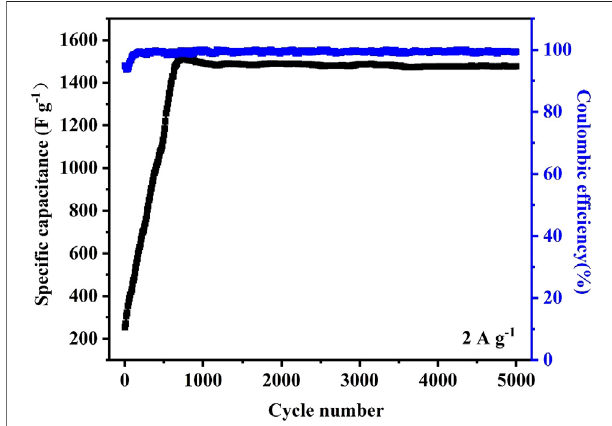
FIGURE 8 | Cyclic performance of CoNi2 hybrid under the current density of 2 A g − 1 .